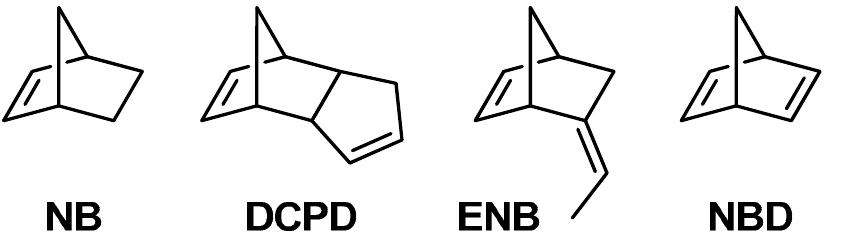
Table 1. Polymerization of NB, DCPD, ENB, NBD promoted by 1 – 2 precatalysts. a